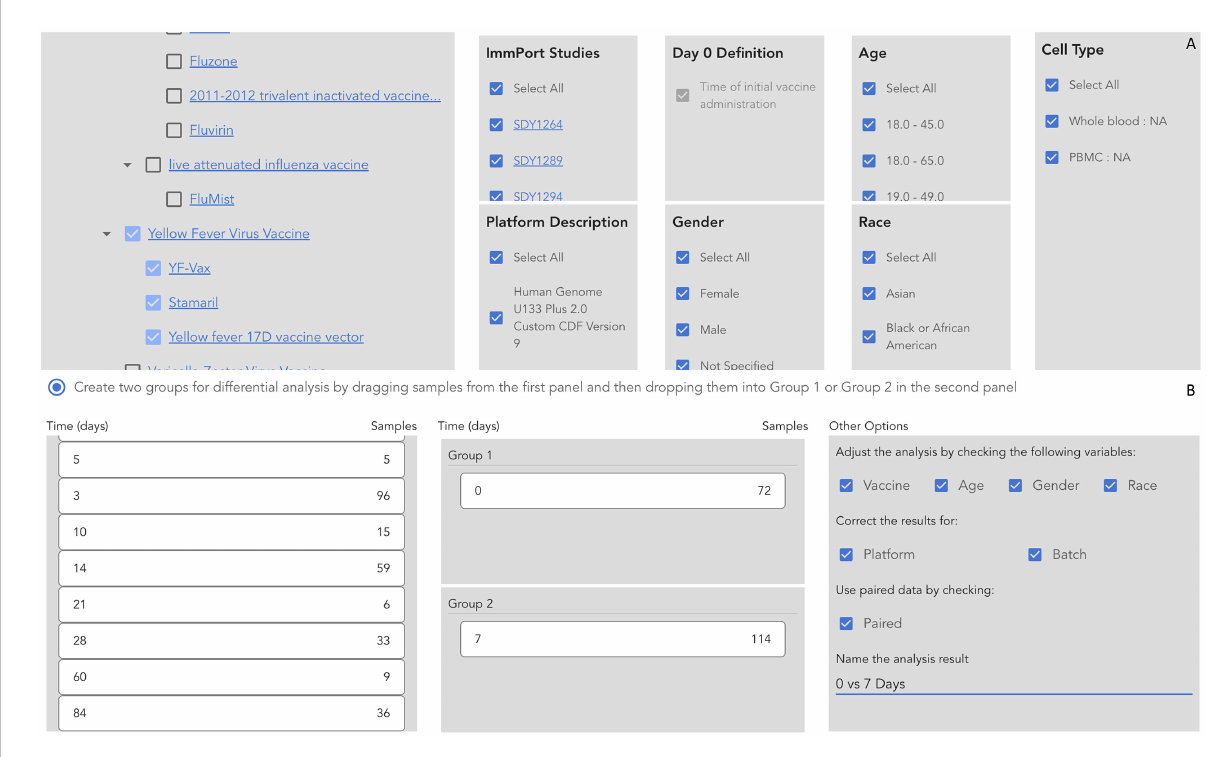
FIGURE 3 Setup parameters and the analysis model to conduct the longitudinal analysis of immune responses to yellow fever vaccines using VIGET. (A) Select vaccines and other parameters to select samples for the analysis. (B) Choose time points and select confounding variables for differential gene expression analysis.